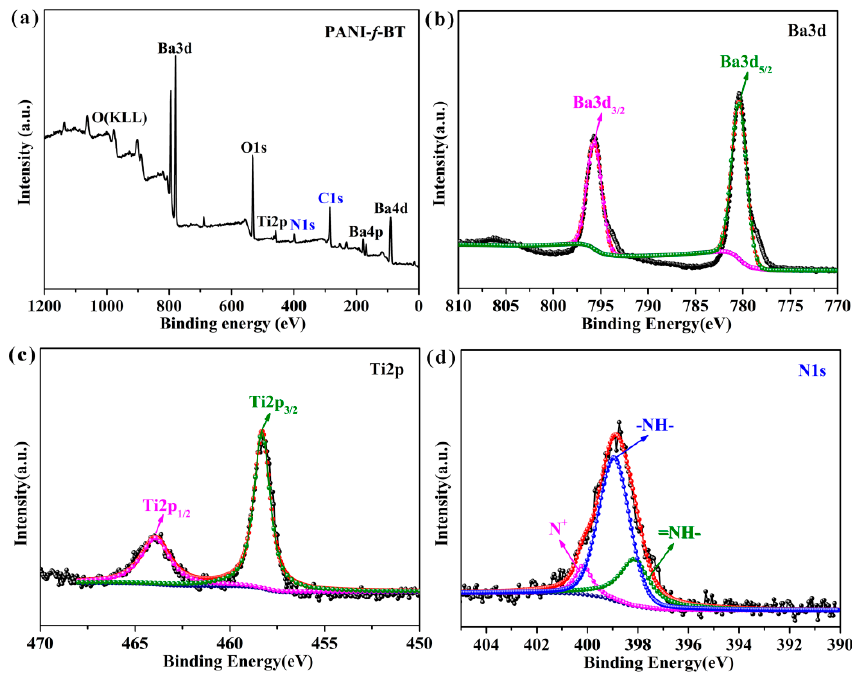
Figure 3. The X-ray photoelectron spectroscopic instrument (XPS) spectrum of PANI- f -BT-b: ( a ) full scanned spectrum; ( b ) Ba3d; ( c ) Ti2p; ( d ) N1s.